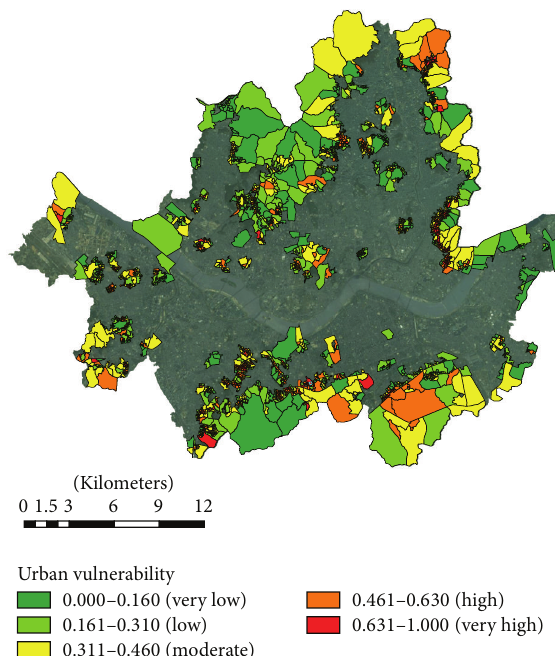
Figure 10: Urban vulnerability to landslide